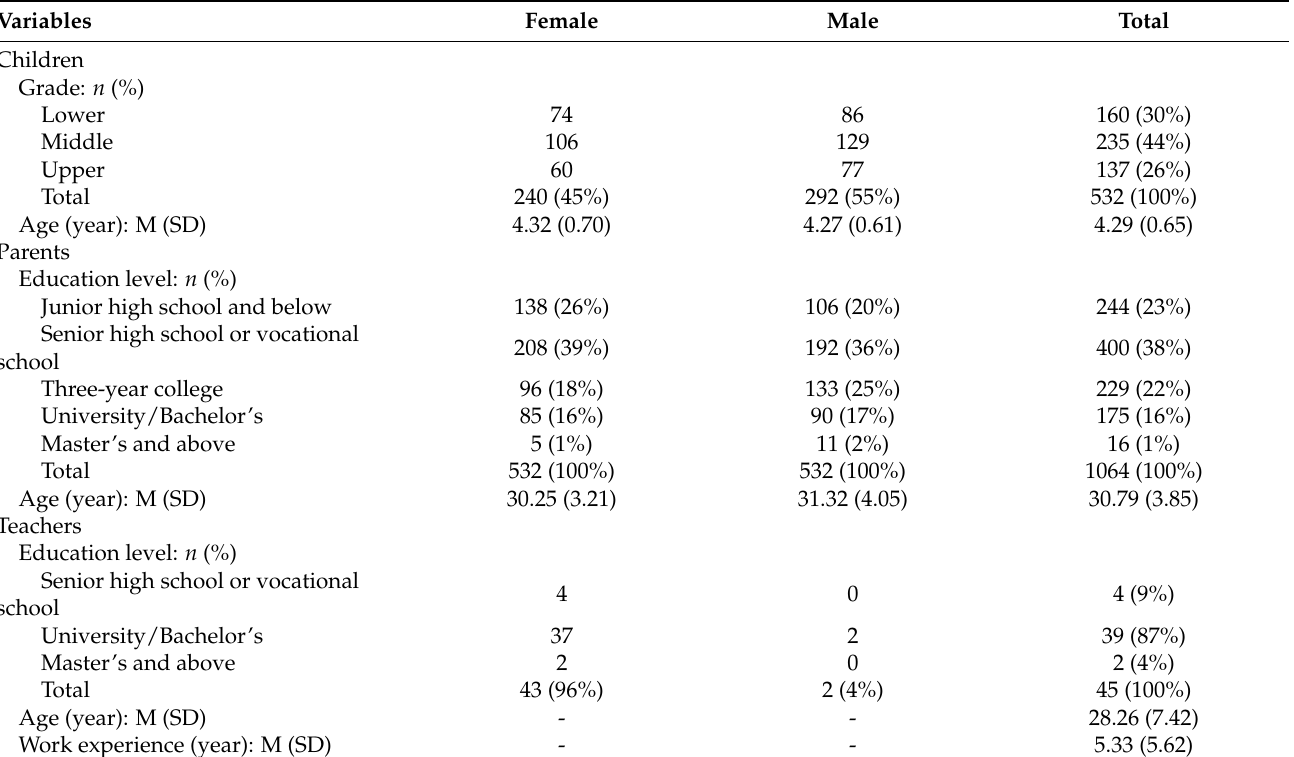
Table 2. Demographic